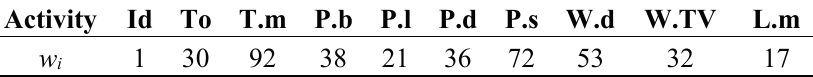
Table 6. Selection of the weights w i using TAP80F dataset.